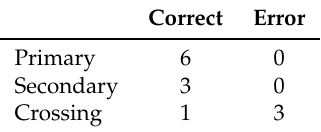
Table 1. Sag model recovery performance on the Hounslow dataset.